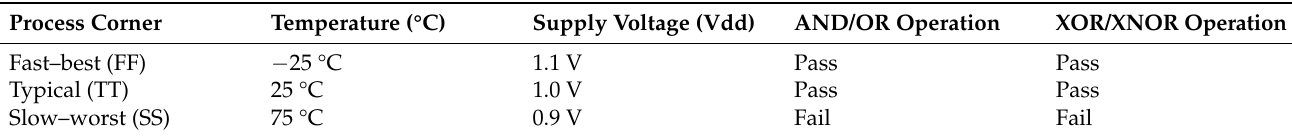
Table 3. Performance of spintronics PGs at various process corners with 3% variation in specific MTJ parameters.